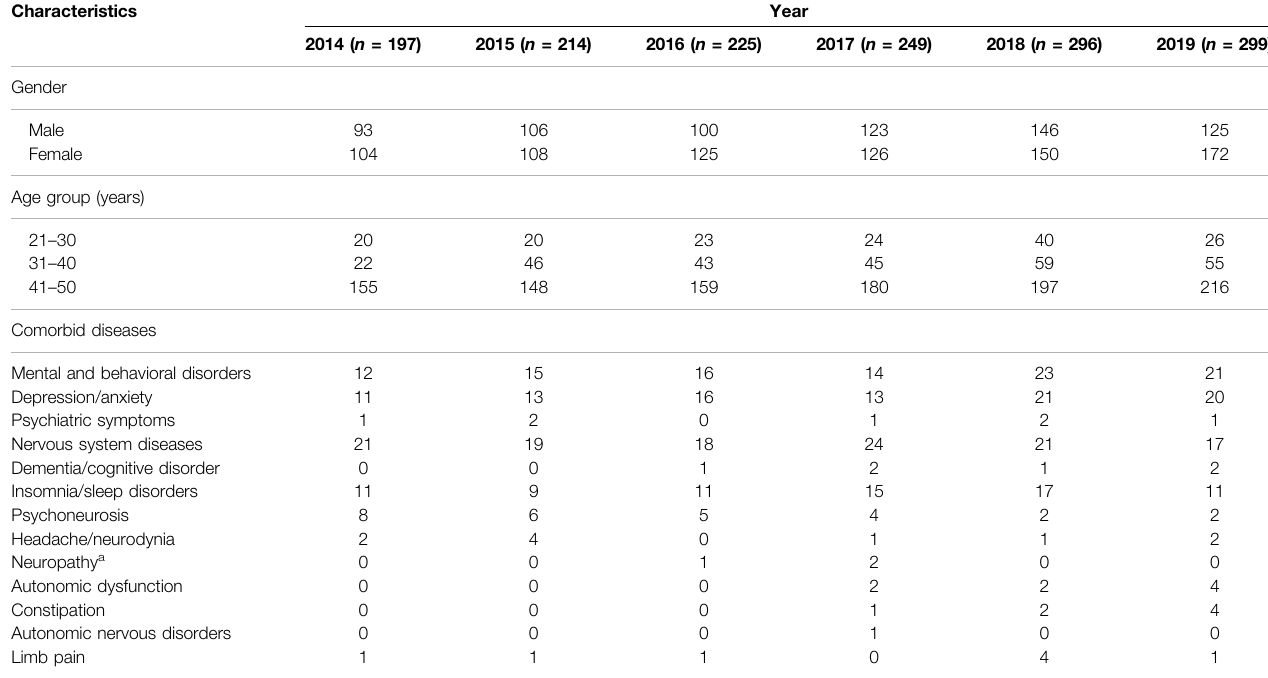
TABLE 1 | Demographic characteristics of patients with young-onset Parkinson ’ s disease from 2014 to 2019 based on each year.